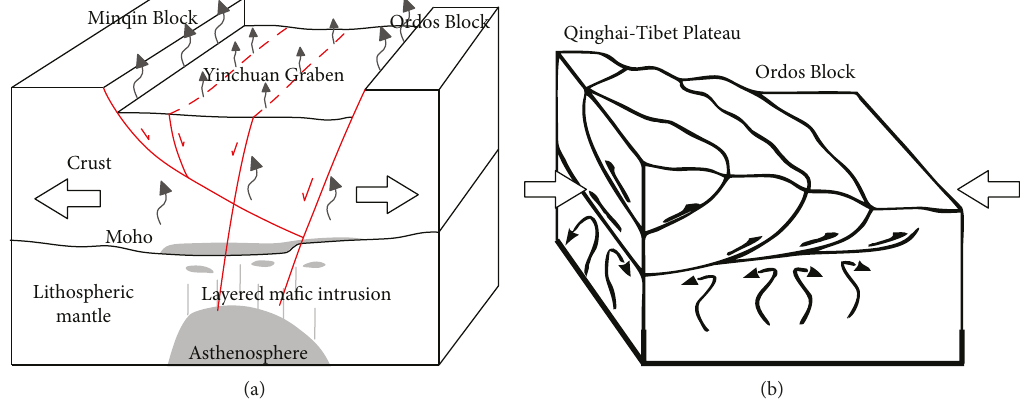
Figure 4: Models of earth degassing throughout (a) the Yinchuan Graben and (b) the Haiyuan Block. In (a), the extensional tectonic setting provides pathways (fractures) of gas migration (modi fi ed after [35]). In (b), the compressional tectonic setting creates overlapping structures that inhibit the rise of deep gases (modi fi ed after [6]).